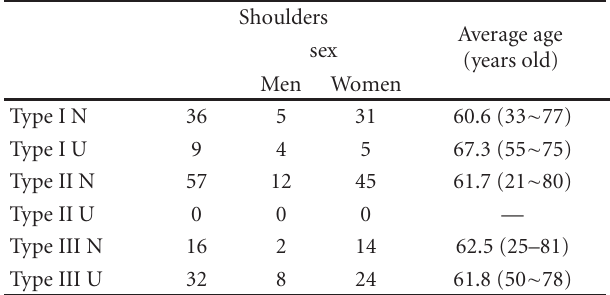
Table 2: Numbers of shoulders and average age into each